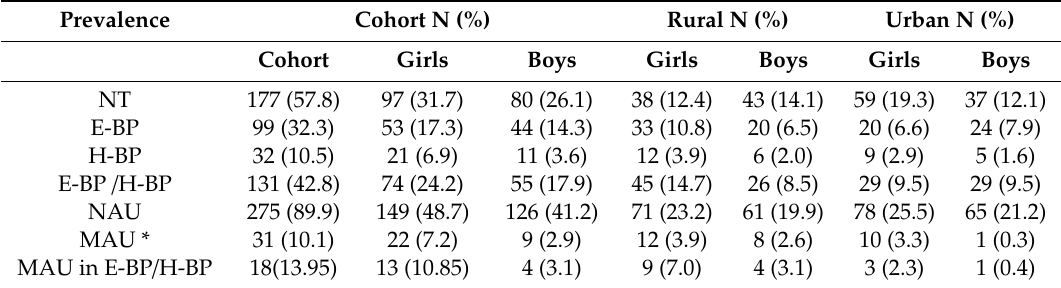
Table 2. High blood pressure and microalbuminuria among children.